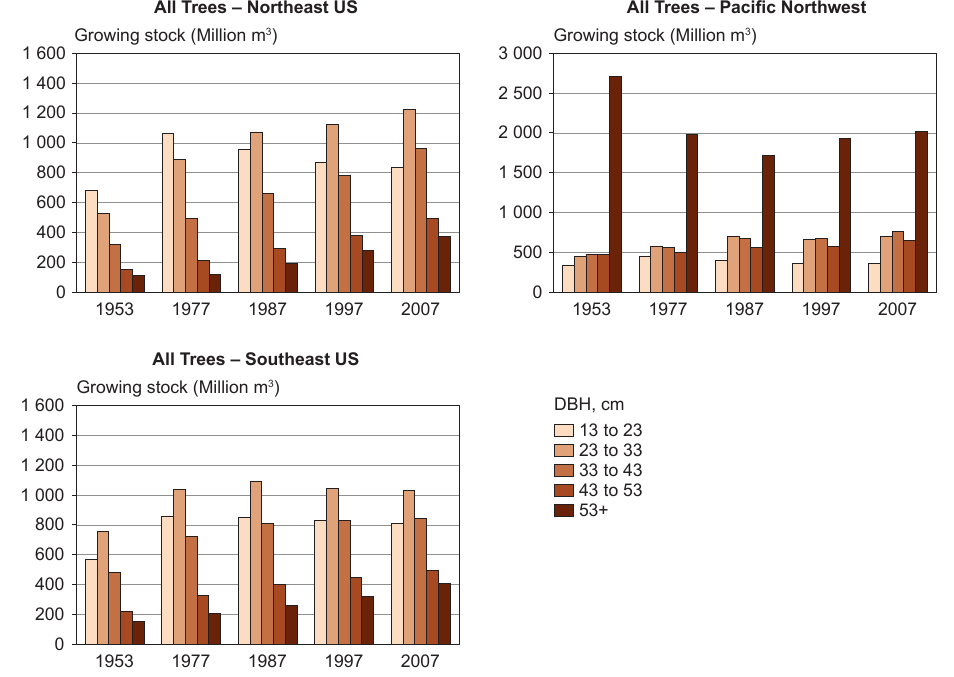
Figure 3. The distribution of growing stock by the size classes from 1953 to 2007 in regions within the United